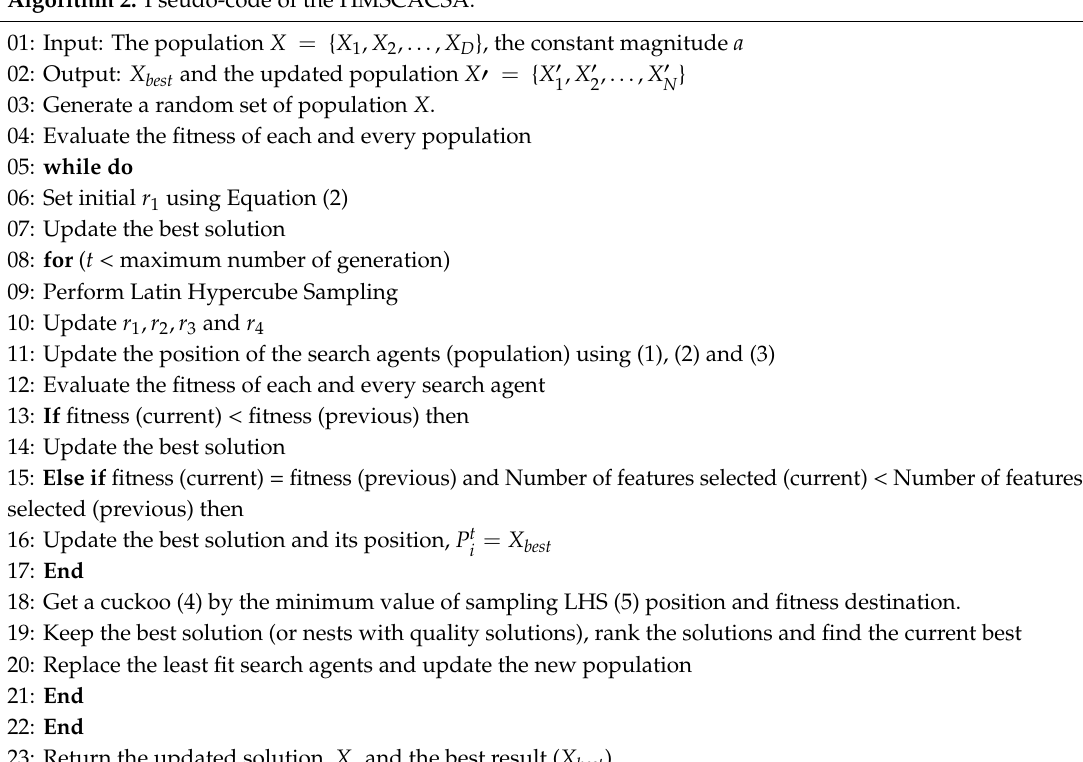
Algorithm 2. Pseudo-code of the